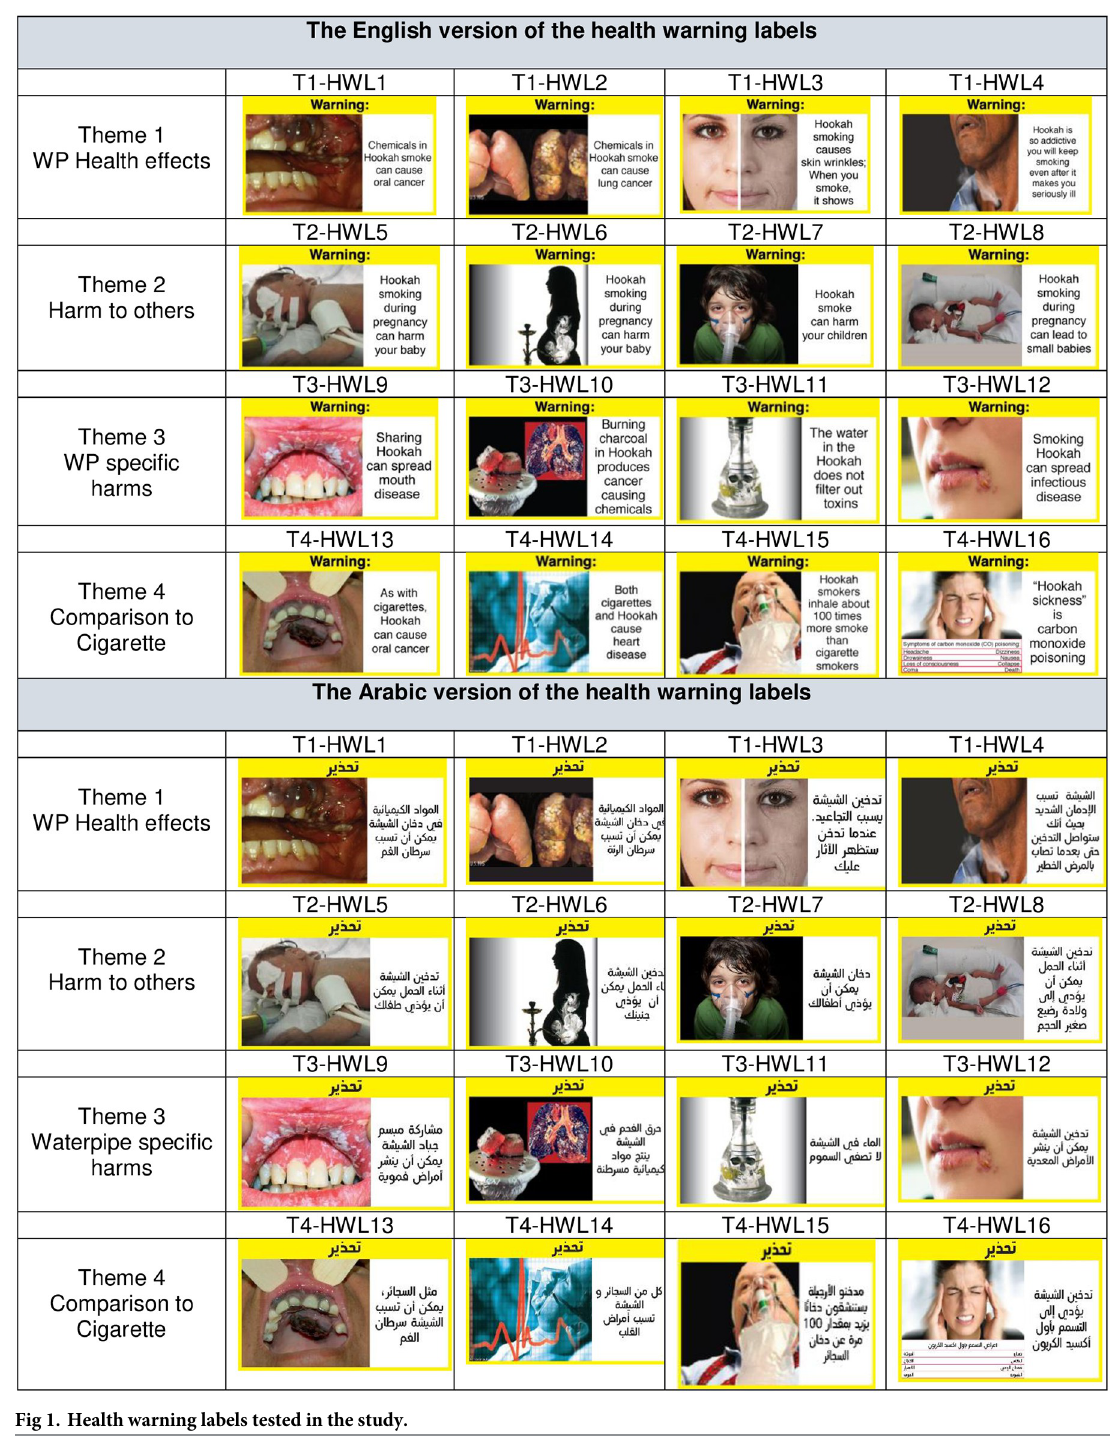
Fig 1. Health warning labels tested in the study.